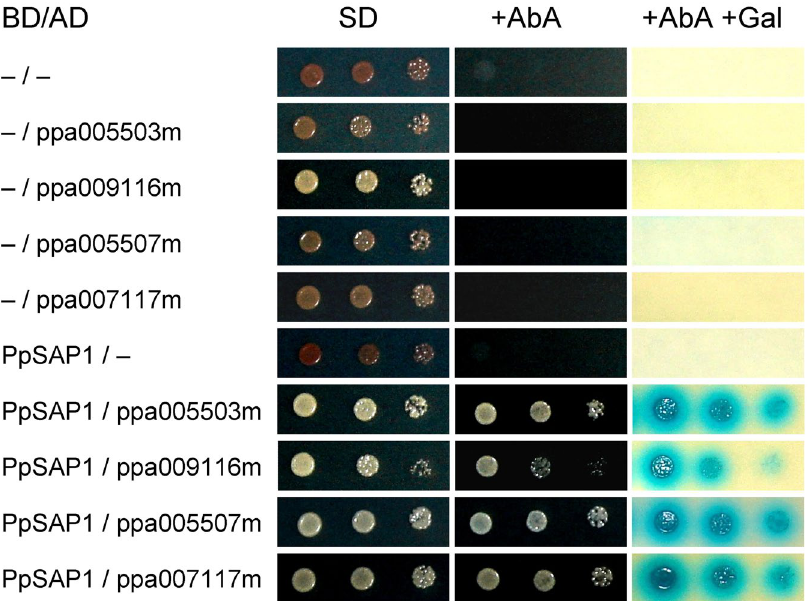
Figure 4. Two-hybrid system analysis of protein interaction. Different combinations of DNA-binding domain (BD) and activation domain (AD) fused with PsSAP1, ppa005503m, ppa009116m, ppa005507m and ppa007117m, and control plasmids ( − ) are shown. Yeast strains were grown on a minimal medium (SD), a growth selective medium containing Aureobasidin A ( + AbA) and a chromogenic medium containing Aureobasidin A and X- α -Gal ( + AbA +